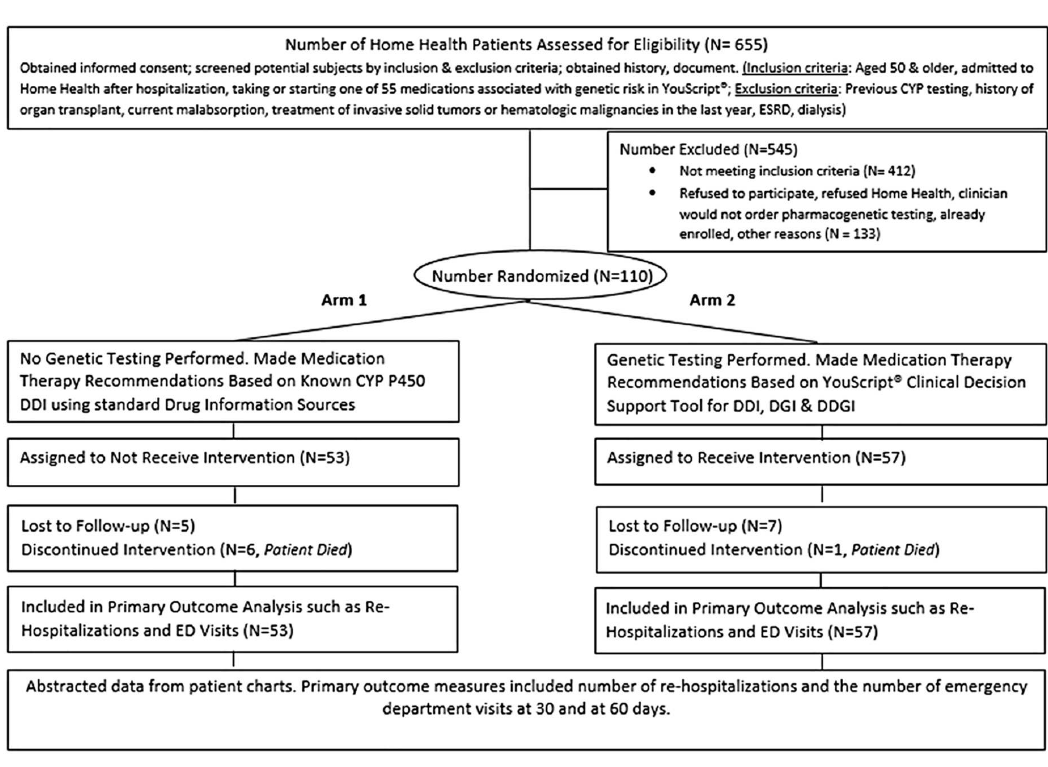
Fig 1. Patient selection flow chart. Of 655 home health patients assessedfor eligibility,412 did not meet the inclusion criteria and 133 patients either declinedto participate, refused home health, already enrolledor the clinicianwouldnot order pharmacogenetic testing. Of 110 randomly allocatedpatients, 53 patients in arm 1 were assignedto not receive intervention and 57 patients from arm 2 were assignedto received pharmacogeneticintervention.CYP, cytochrome; DDI, drug-druginteraction; DGI, drug-geneInteraction; DDGI, drug-drug-gene interaction; ED, emergency department; ESRD, end stage renal disease;N, numberof patients.